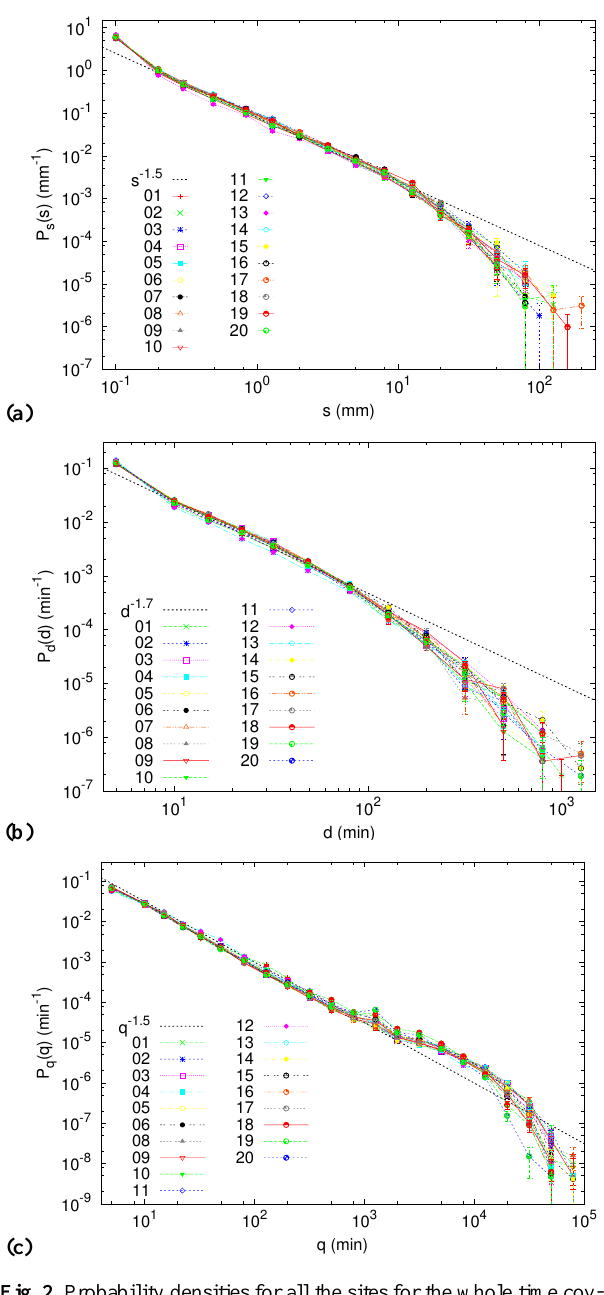
Fig. 2. Probability densities for all the sites for the whole time cov- ered by the record of (a) event sizes, (b) event durations, and (c) dry